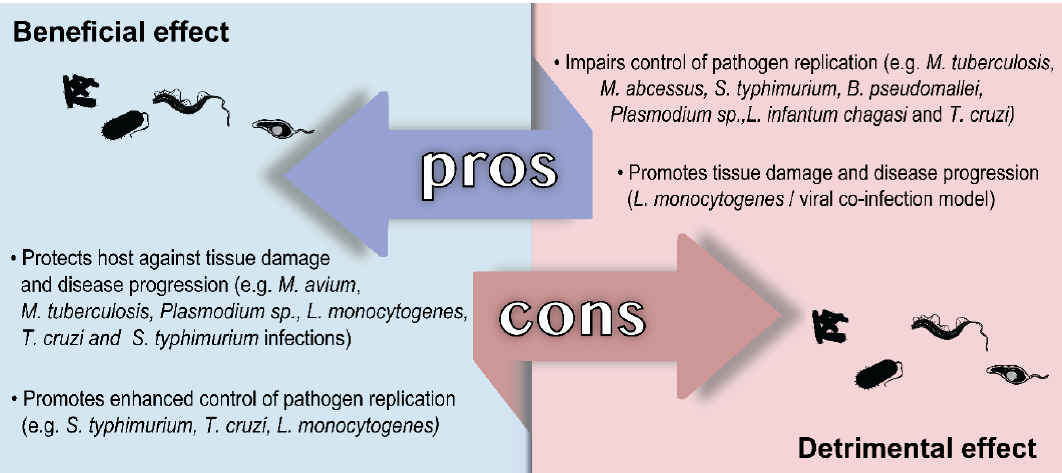
Figure 3. Schematic view summarizing the findings on the beneficial and detrimental roles played by HO-1 in infectious diseases caused by different intracellular pathogens.